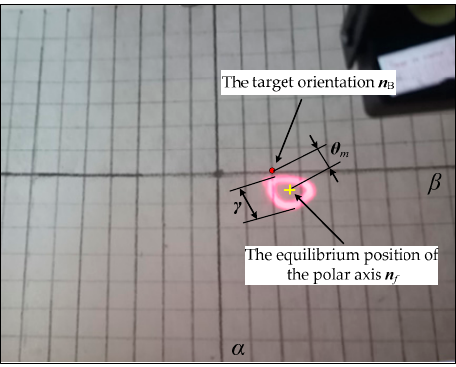
Figure 19. Snapshots of the end motion trajectories of polar axis n f of the centroid deviation l = − 4 mm. Table 4. The precession results of the DSCR for different centroid deviation.